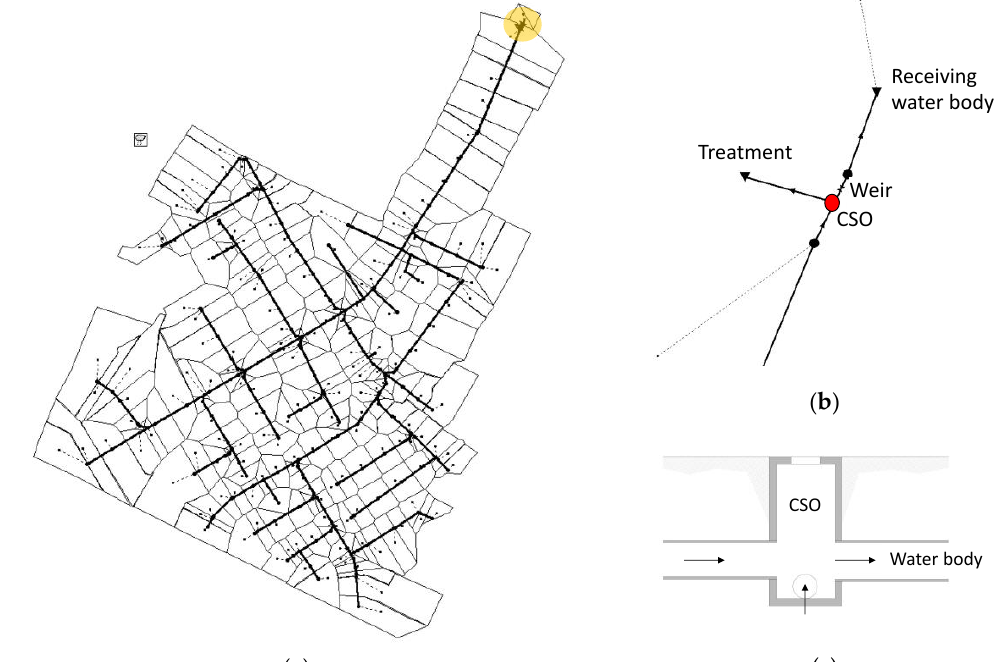
Figure 2. Model geometry: ( a ) Storm Water Management Model (SWMM) representation of the sewer network, where the yellow dot indicates the outfall of the system; ( b ) zoomed-in view of the model of the combined sewer overflow (CSO) located at the end of the system and ( c ) relative section. Table 1. Main parameters obtained from model calibration in SWMM